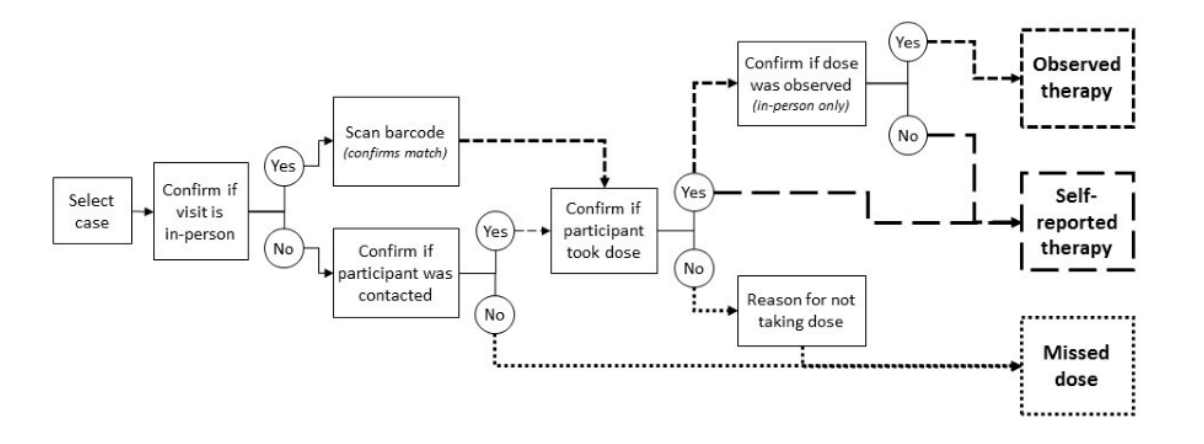
Figure 1. Flow diagram of data collection app for directly observed therapy days (Monday through Friday). Small dashed lines denote pathways to observed therapy. Large dashed lines denote pathways to self-reported therapy. Dotted lines denote pathways to a missed dose